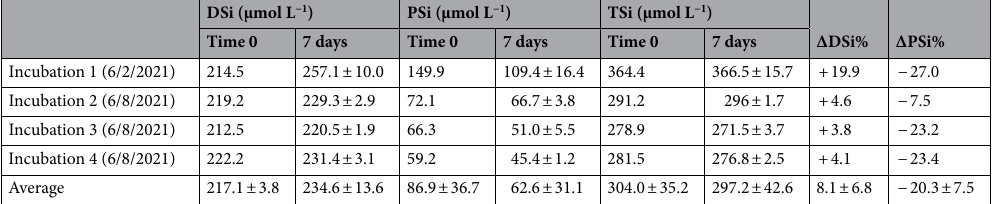
Table 1. Results of the PSi dissolution experiment. The results at time 0 and the time of 7 days indicate the concentrations of STP influent before and after the incubation experiment, respectively. ΔDSi and ΔPSi show the rate of change in DSi and PSi concentration from before to after the incubation